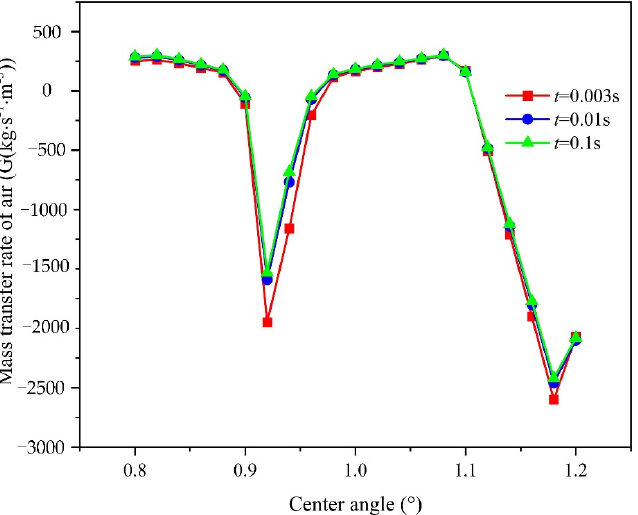
Figure 18. Mass-transfer rate of air at different times in a single cylindrical textured dimple.